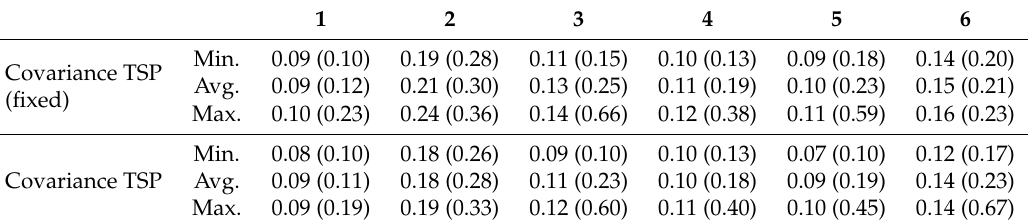
Table 3. The ratio of the trace sum at the start of revisiting to the end.